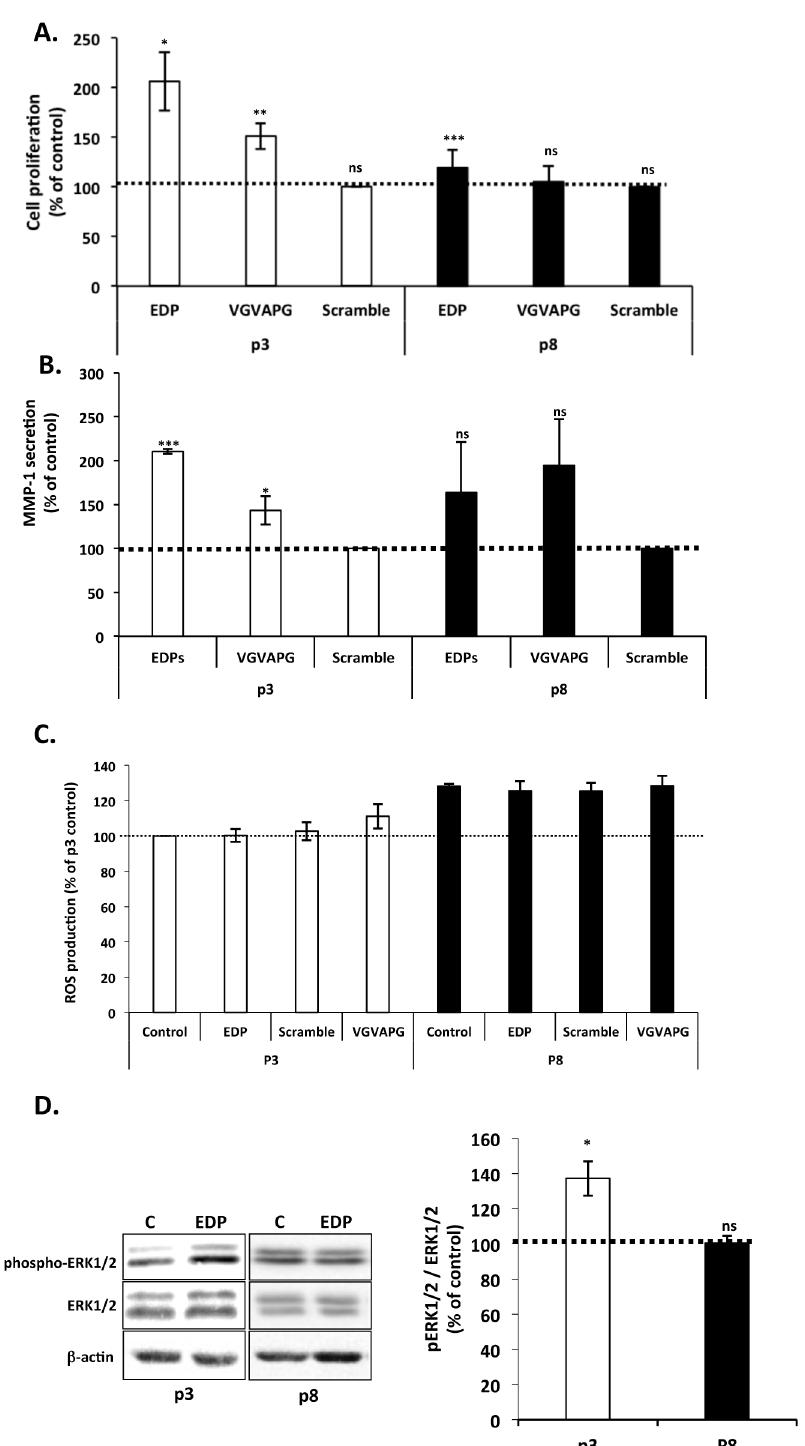
Fig 2. Impact of in vitro aging on EDP biological effects. Young and aged fibroblasts were represented by passage 3 (white) and 8 (black bars), respectively. Dotted lines (100%) represent the values of the unstimulated controls. (A) Impact of in vitro aging on EDP-mediated fibroblast proliferation. Cells were stimulated or not with 50 μ g/mL of EDP or 200 μ g/mL of scramble or VGVAPG peptides during 48h. Proliferation was analyzed by counting using Trypan Blue exclusion. (B) Impact of in vitro aging on